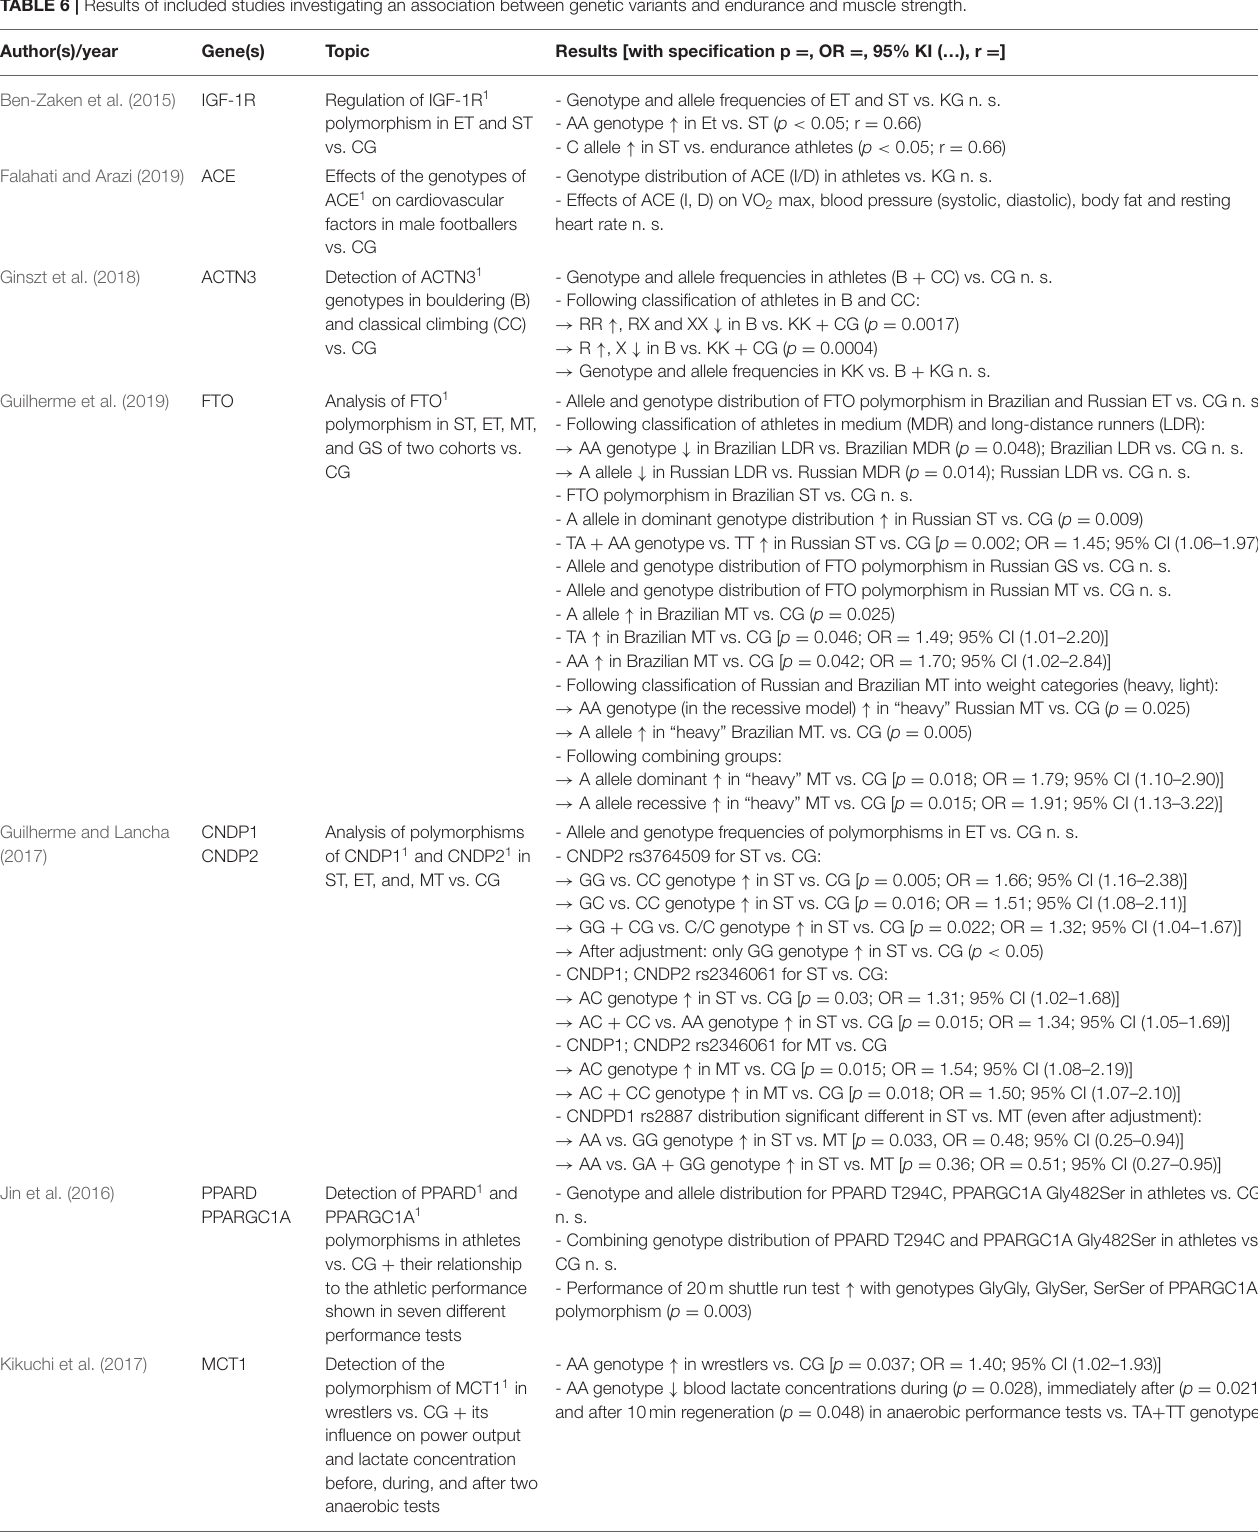
TABLE 6 | Results of included studies investigating an association between genetic variants and endurance and muscle strength.